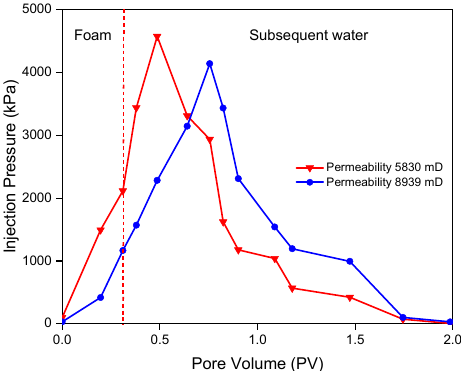
Figure 6. Influence of permeability on injection pressure.